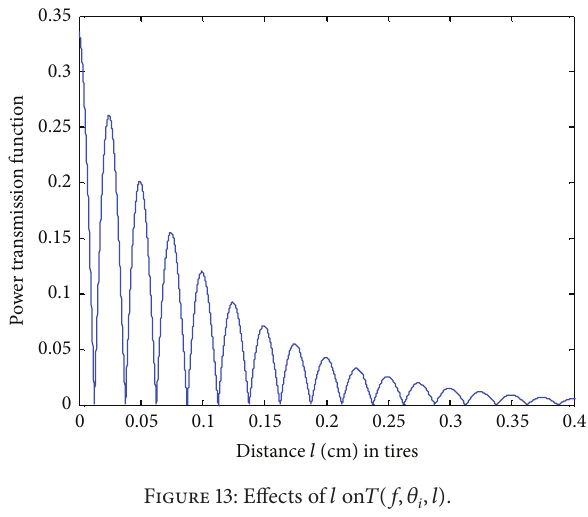
Figure 13: Effects of 𝑙 on 𝑇(𝑓,𝜃 𝑖 , 𝑙) .